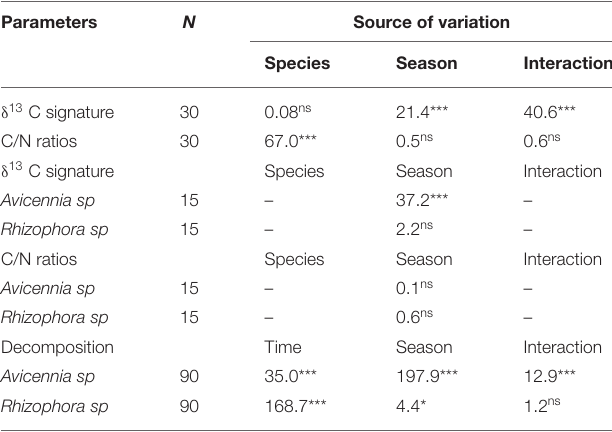
TABLE 1 | Two-way ANOVA tests showing the effect of species and seasons on decomposition rates. Parameters N Source of variation